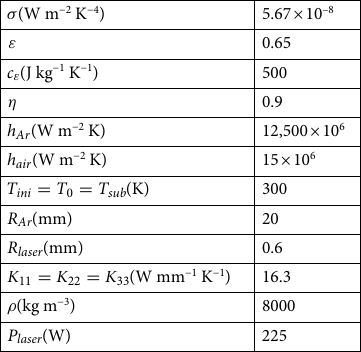
Table 3. Parameters for the FE simulations appearing in Eqs.